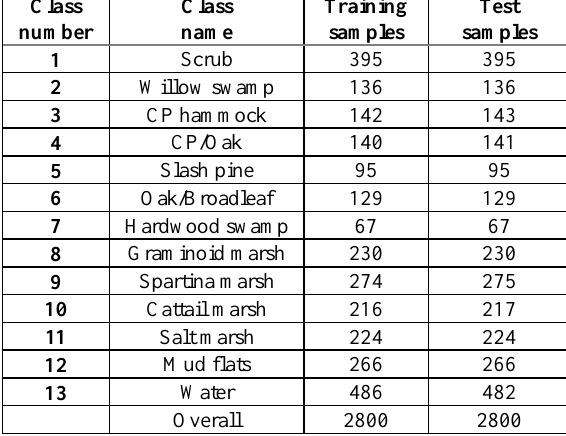
Figure 4 The KSC image and the corresponding ground- truth